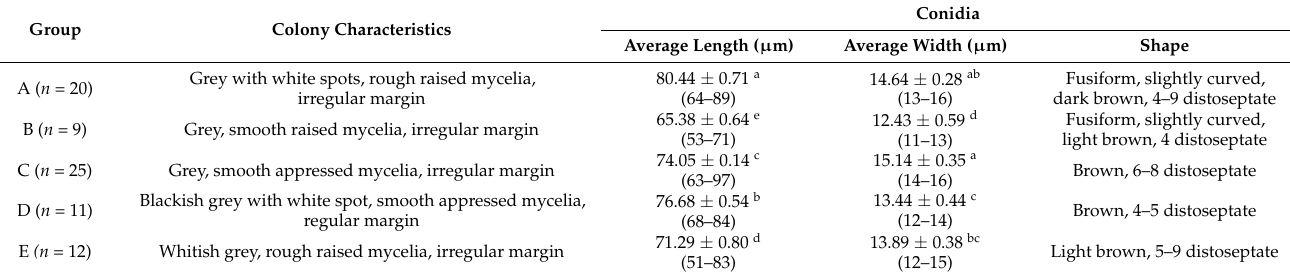
Table 3. Morphological characteristics of Bipolaris